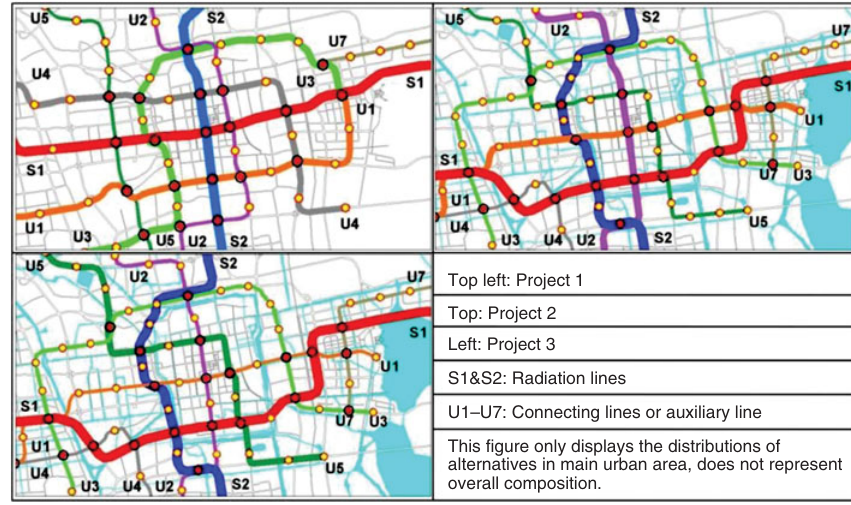
Fig. 3. Layout of three alternative projects in Suzhou’s main urban